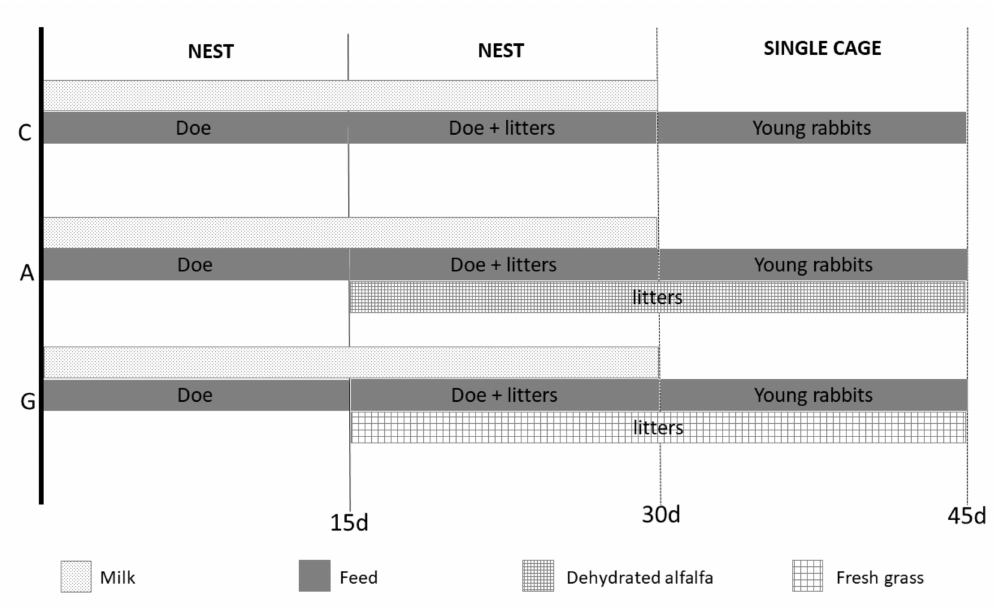
Figure 1. Feeding plan of experimental groups. The dotted bar represents the milking period; the full gray bar represents the pelleted feed administration; the small square bar represents the dehydrated alfalfa period of administration; the big square bar represents the fresh grass period administration. C = rabbit fed pelleted feed only; A = rabbit fed pelleted feed + dehydrated alfalfa; G = rabbit fed pelleted feed + fresh